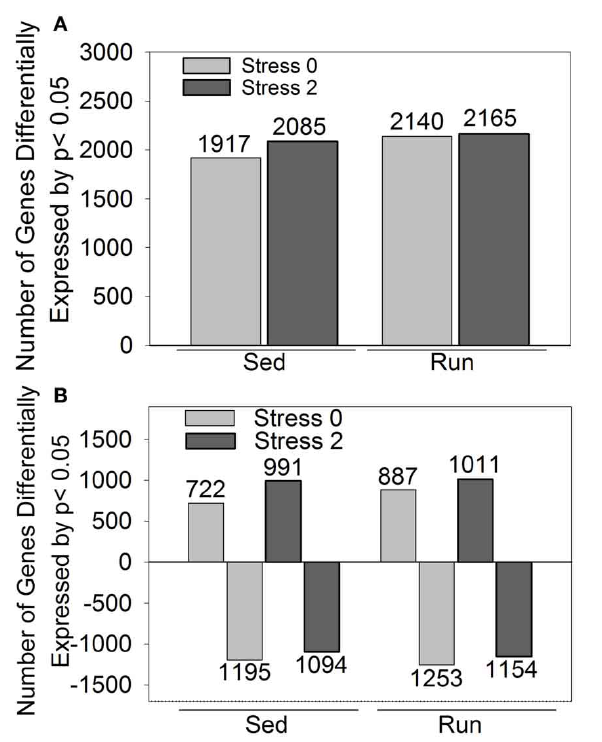
FIGURE 2 | Number of genes differentially expressed by p < 0 . 05 in rats exposed to stress compared to home cage non-stressed controls. (A) Total number of genes differentially expressed. (B) Number of genes differentially upregulated or downregulated.